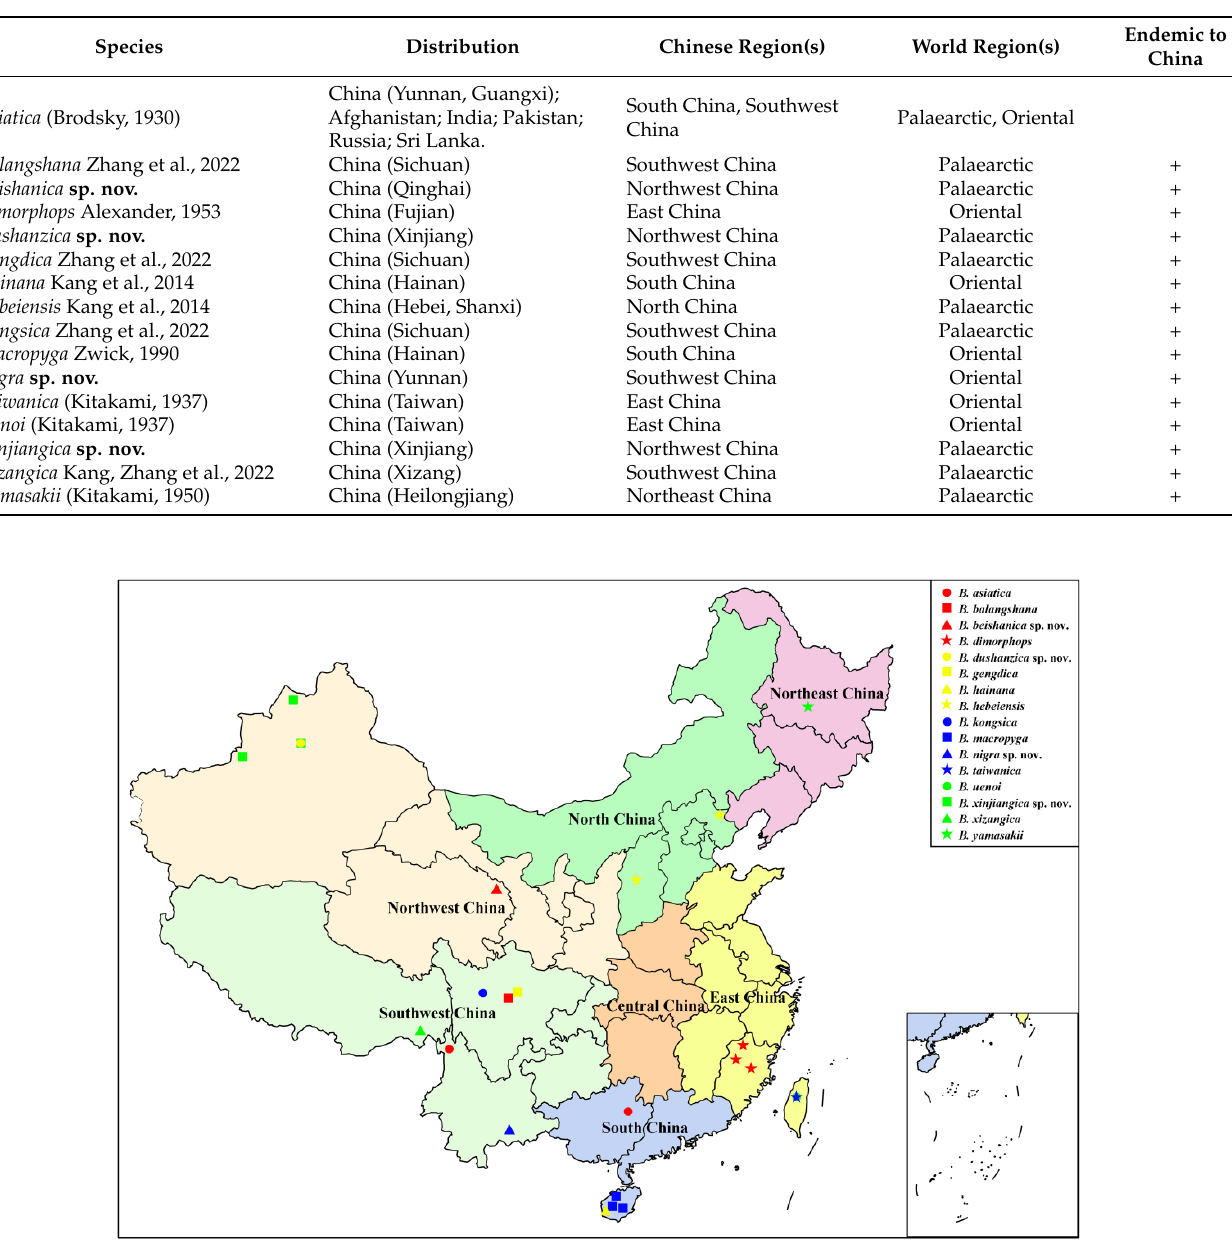
Table 3. Checklist of Chinese Blepharicera species with distribution data.